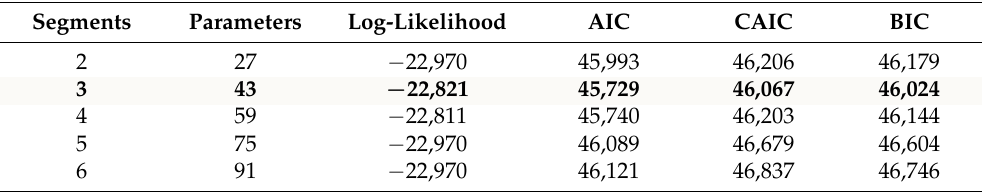
Table 3. Model fit with respect to the number of segments.